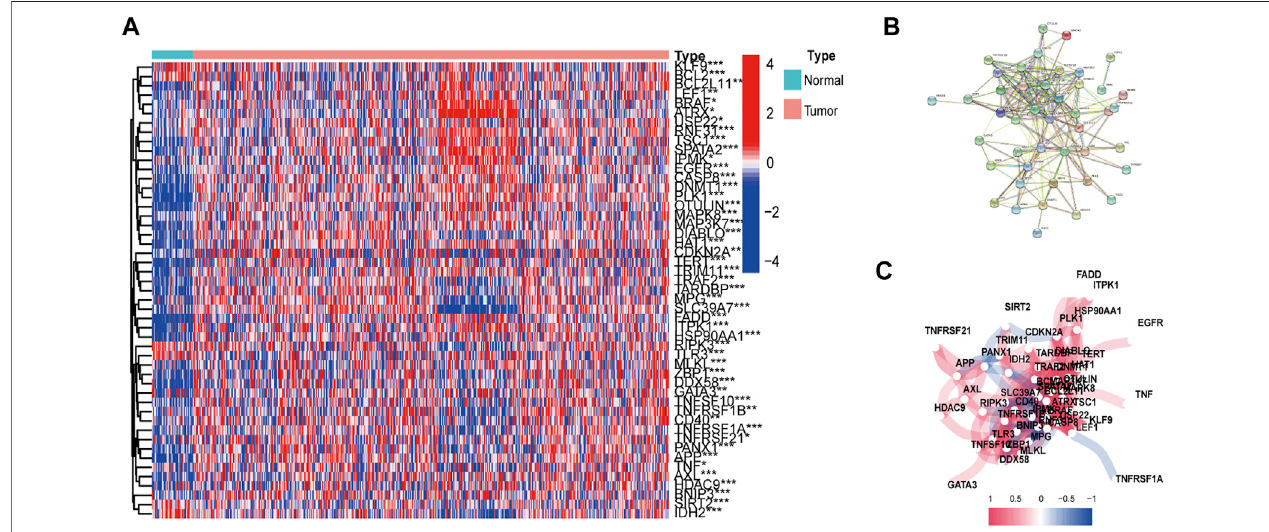
FIGURE 2 | Expressions and interactions of 67 necroptosis-related genes in the normal and tumor tissues. (A) Heatmap of necroptosis-related genes. (B) Gene interactionsrevealedbyPPI. (C) Genecorrelationnetwork(Redandbluelinesindicatepositiveandnegativeassociationrespectively).* p < 0.05;** p < 0.01;*** p < 0.001, tumor vs. normal